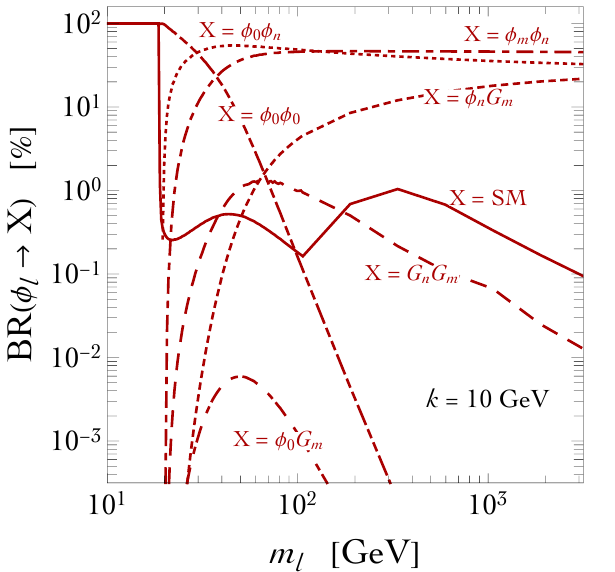
Figure 7 . Branching ratios of the scalar KK modes (cid:30) l ! X for k = 10 GeV, rigid boundary conditions and vanishing curvature-Higgs interaction from eq. (2.55).